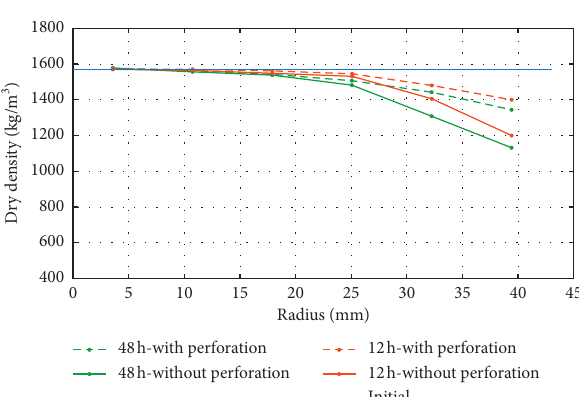
Figure 7: Maturation of dense clay with and without perforated tubes for 12 and 48 hours,